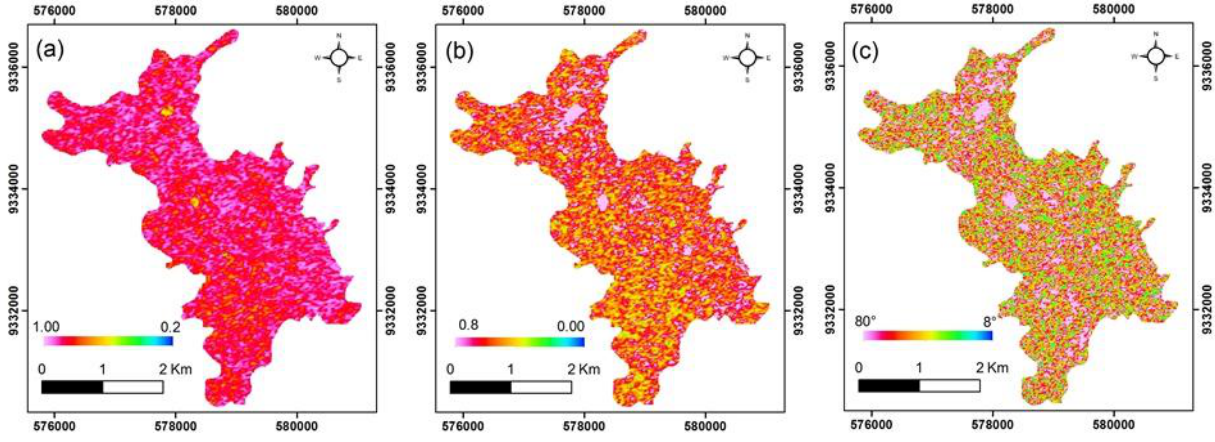
Figure 6. RADARSAT-2 image classified by the decomposition method: ( a ) based on the H- reference plane; ( b ) the H- -A reference